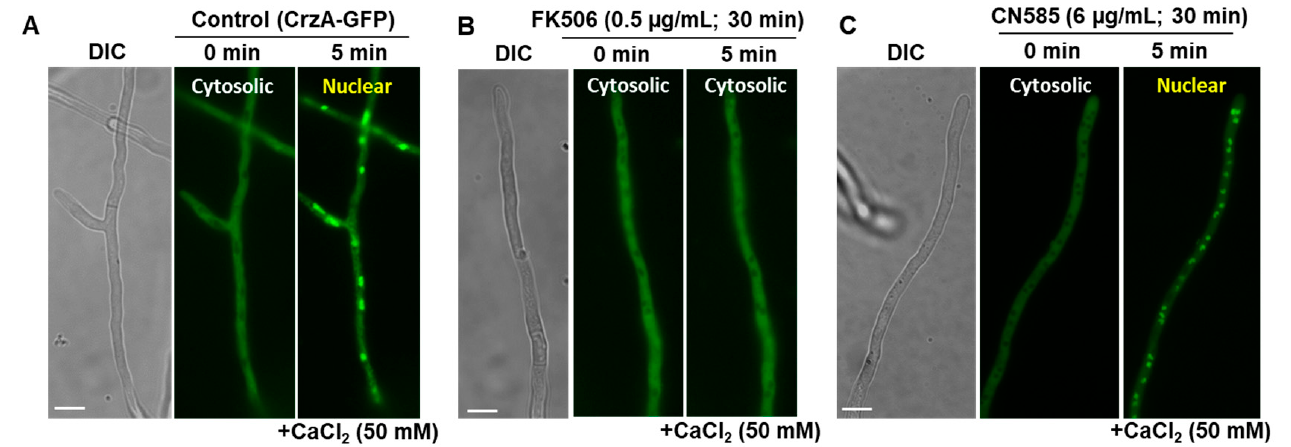
Figure 4. Microscopic localization CrzA-GFP in A. fumigatus in the absence or presence of FK506 and CN585. ( A ) Nuclear localization of CrzA-GFP under control conditions. ( B ) Inhibition of nuclear localization of CrzA by FK506. ( C ) Nuclear localization of CrzA-GFP under CN585 treated conditions. DIC-Differential Interference Contrast; Scale bar, 10 µm.